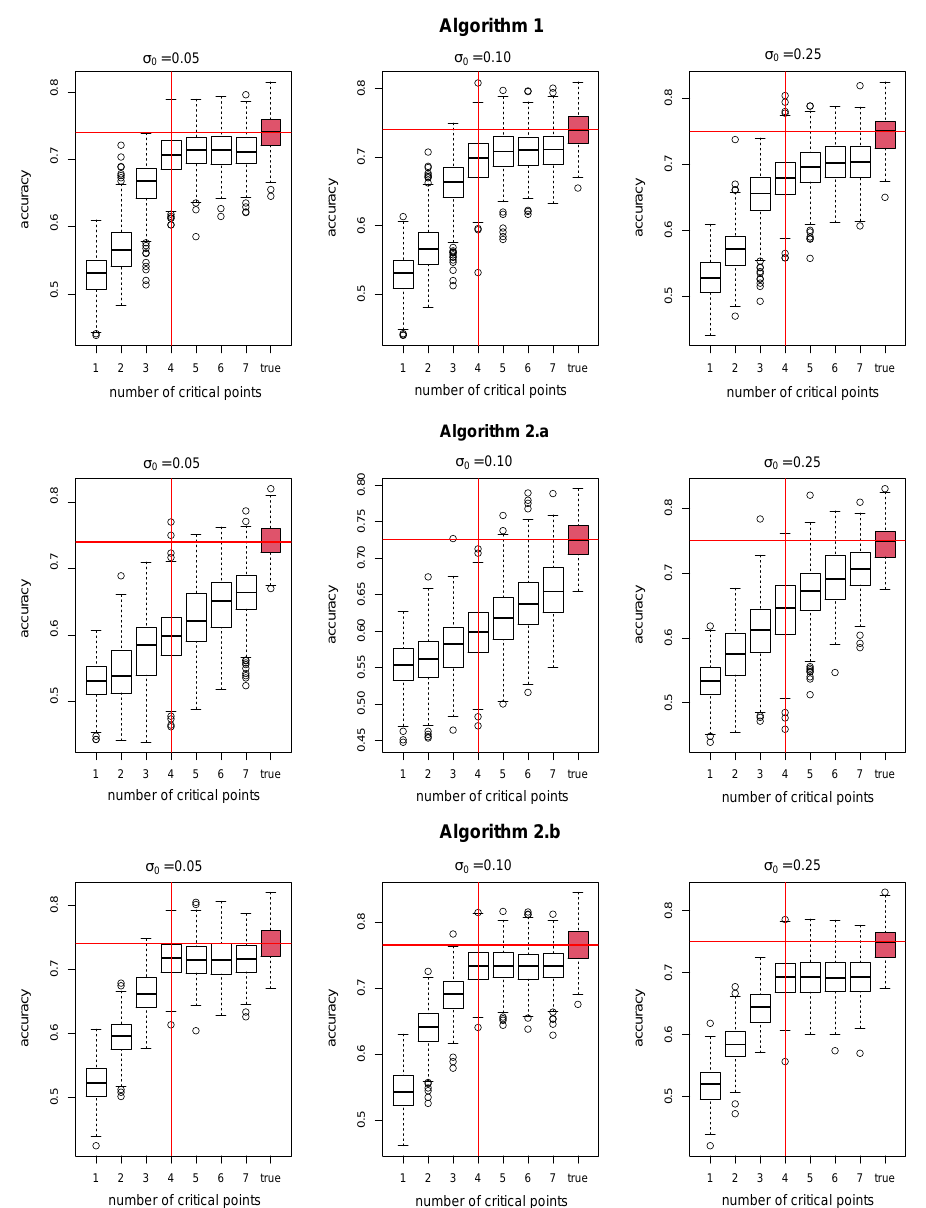
Figure 3. Boxplots of the total accuracy obtained with the three algorithms: 1 ( top ), 2.a ( middle ), 2.b ( bottom ). The theoretical value of these metrics in given by the red line. The red boxplot corresponds to the theoretical